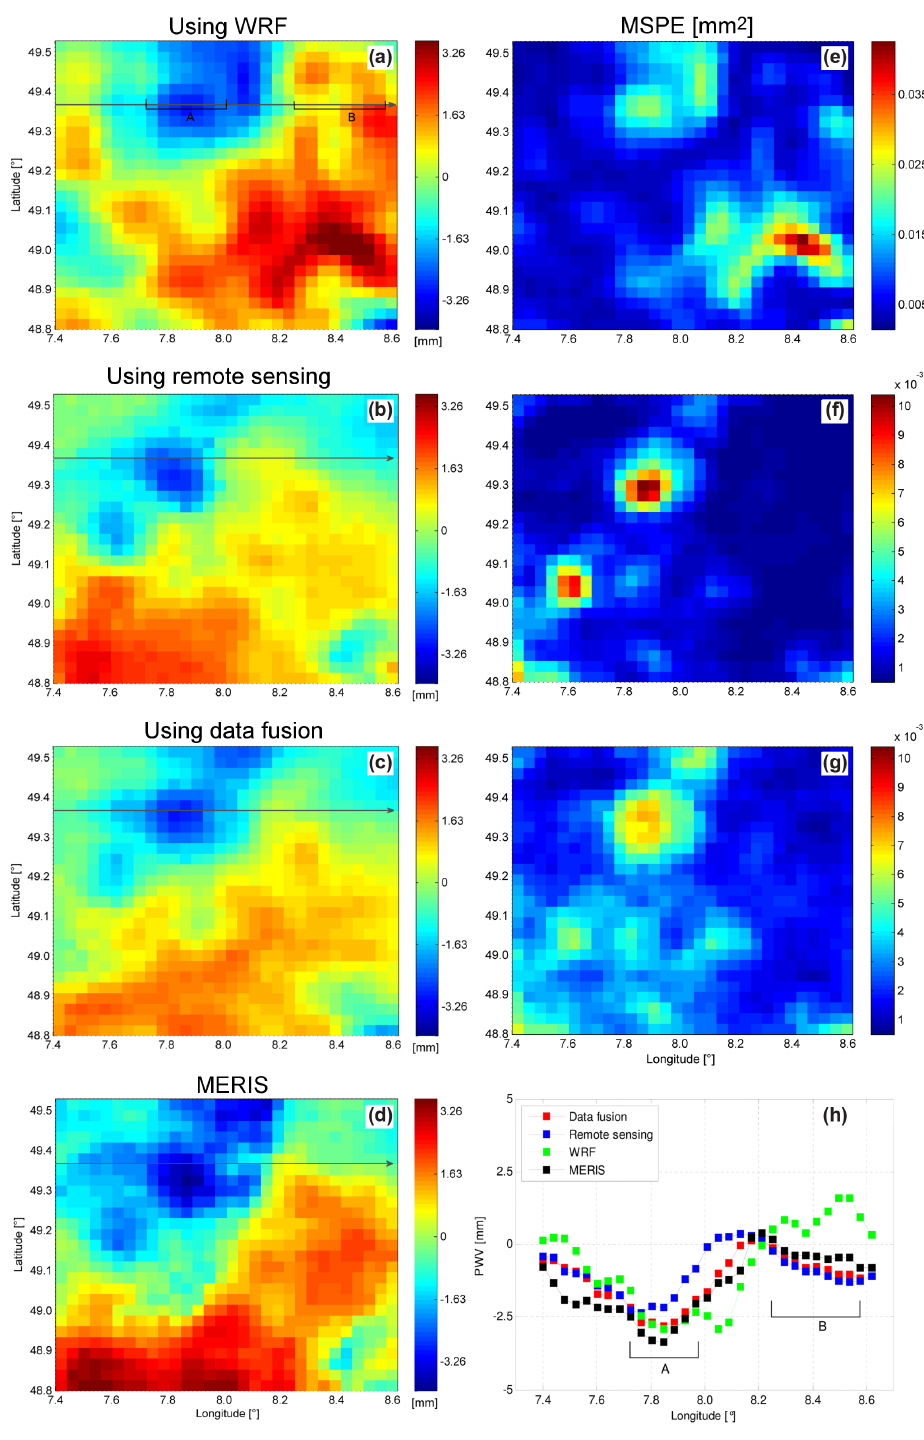
Figure 12. PWV prediction and MSPE maps obtained by data fusion of PWV estimates from PSI and GNSS and maps from WRF as well as predictions obtained by applying FRK to individual data sets. The data are available on 5 September 2005 at 09:51UTC. The output grid has a block size of 3km × 3km. The label A defines a region of sparse remote sensing data and the model data in region B are highly